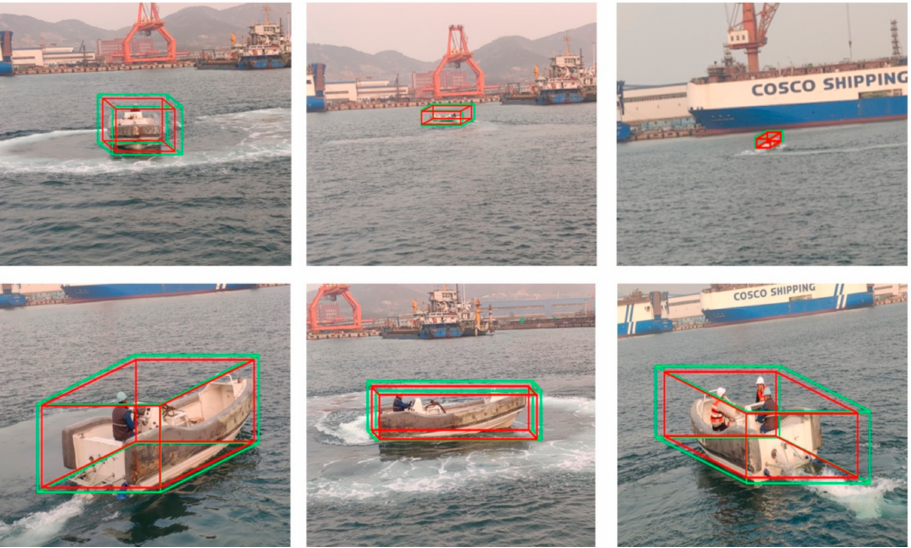
Figure 8. Test result of the object detection tasks in actual application (in different positions, sizes and